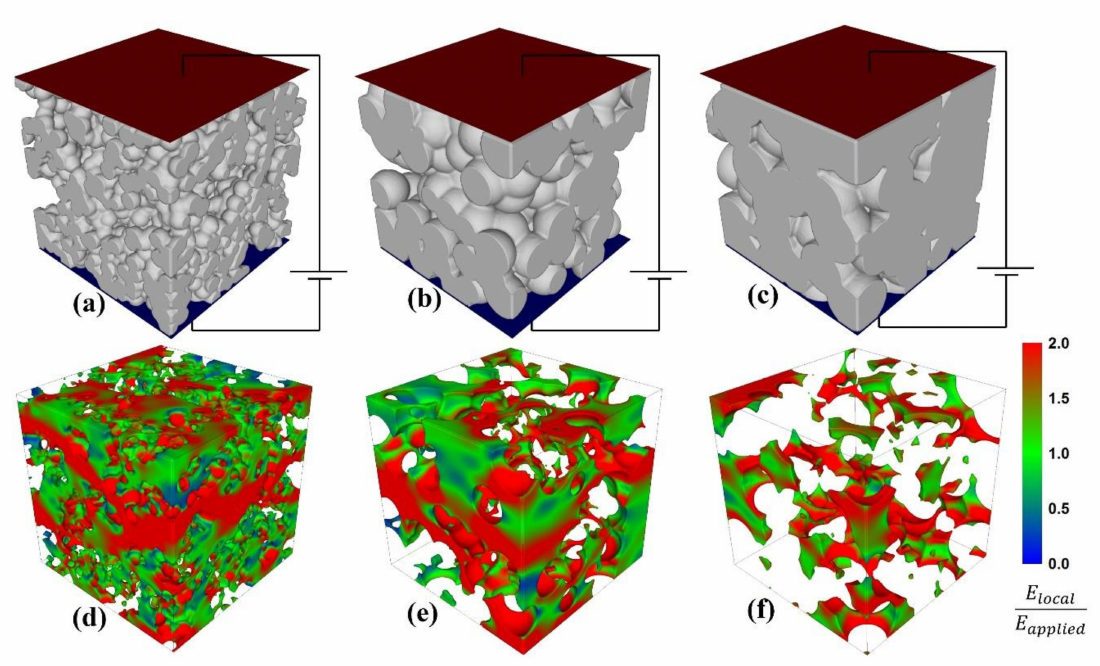
Figure 3. Representations of local field images in pores: ( d – f ) in color scale corresponding to 3 ceramics with di ff erent grain sizes and porosity levels; ( a – c ) in a parallel-plate capacitor configuration (red surface—top electrode; blue surface—bottom electrode). The grain sizes and porosity levels of the systems are 0.45 µ m and 28% ( a , d ), 1.07 µ m and 17% ( b , e ) and 1.44 µ m and 6% ( c , f